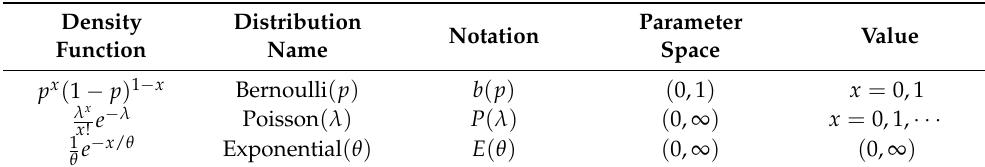
Table 1. Distribution families investigated in